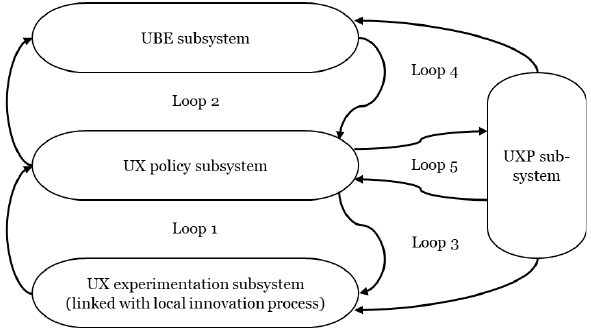
Figure 1 . Policy structure diagram as decomposition of